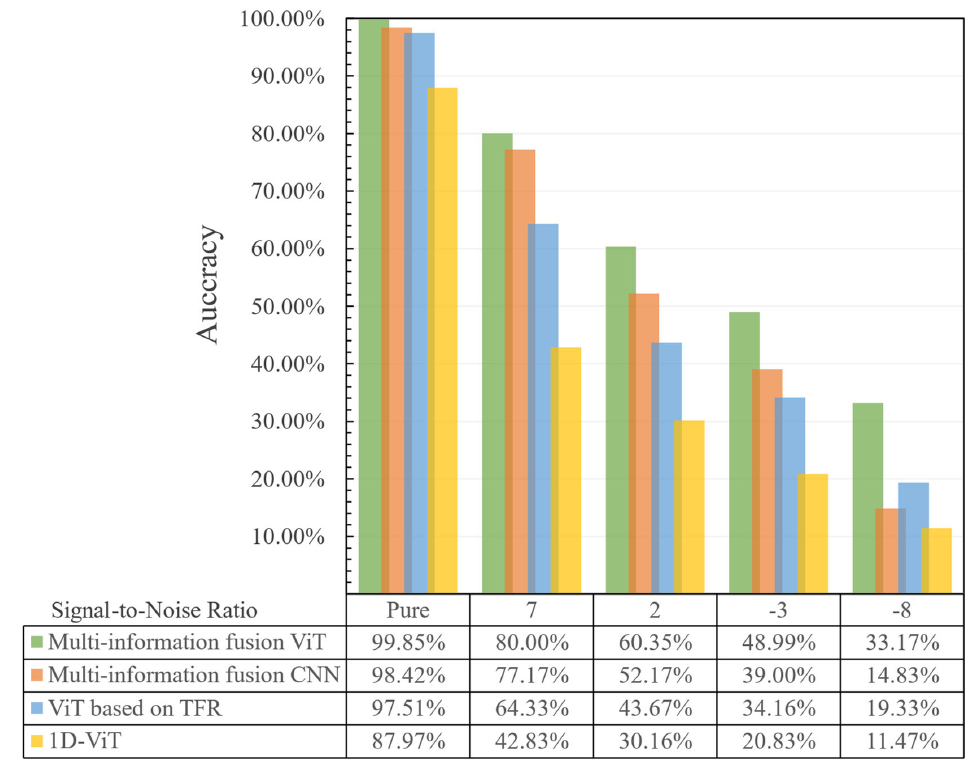
Figure 12. Diagnostic accuracies of the different fault diagnosis methods at different signal ‐ to ‐ noise ratios.